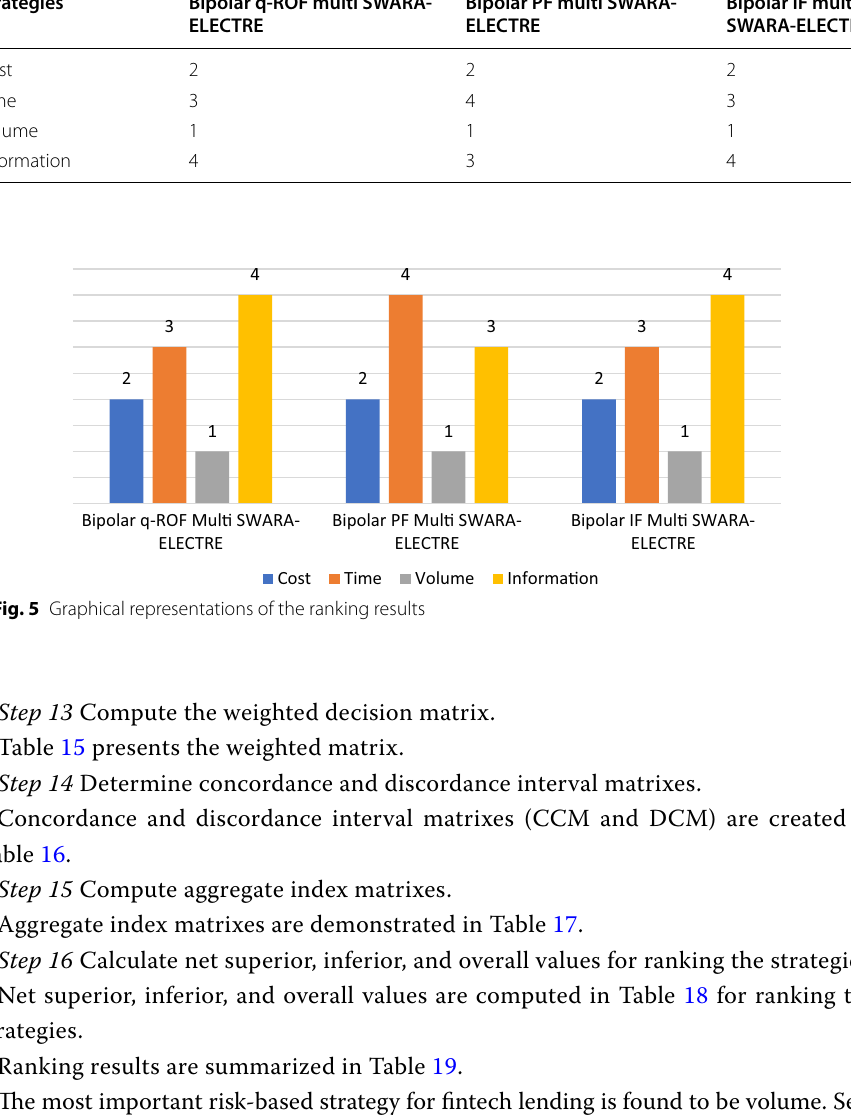
Table 19 Comparative overall ranking results for the risk-based strategic priorities of fintech lending Strategies